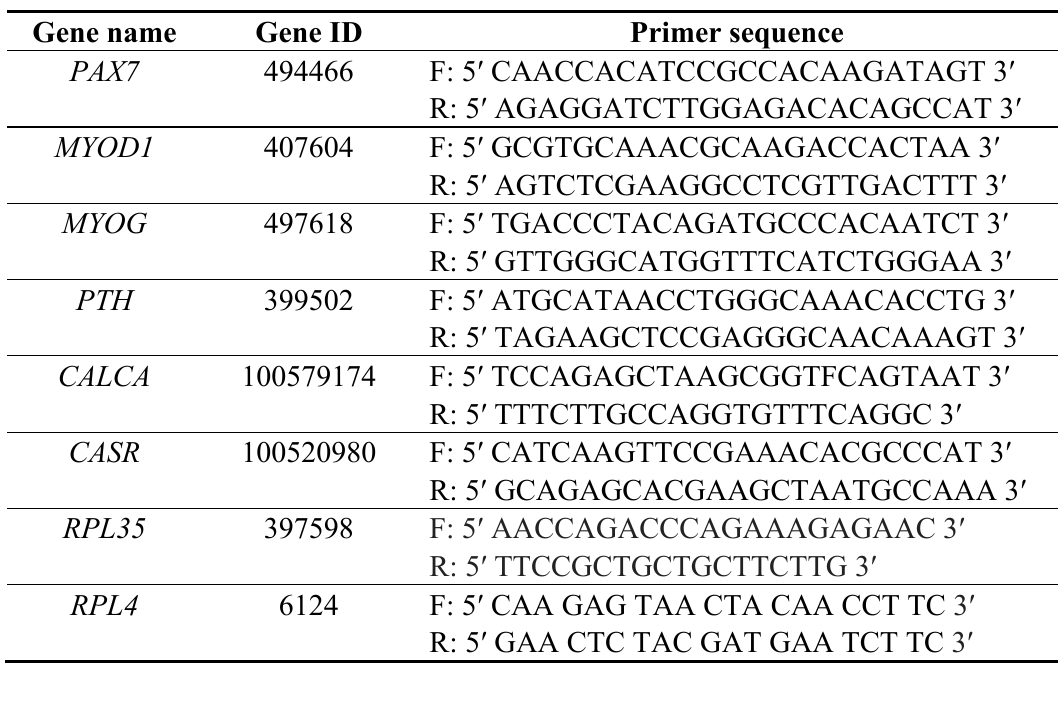
Table 2. Primers used for quantification of gene expression by real-time